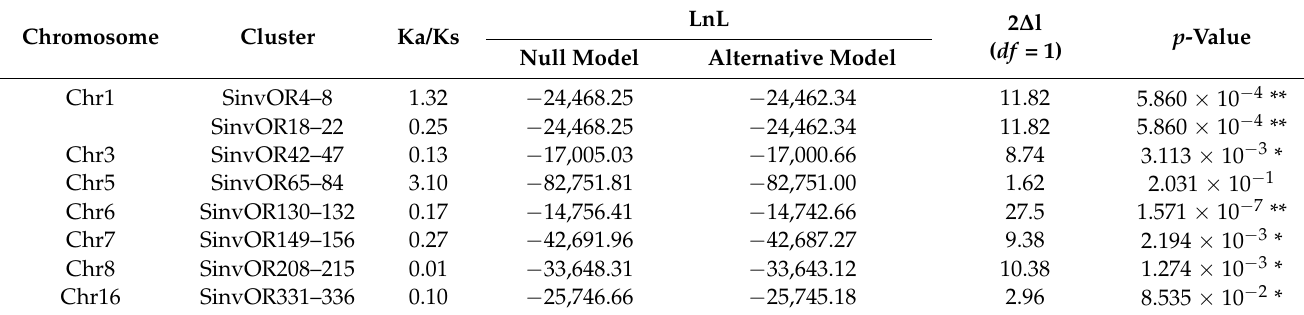
Table 1. Selective evolutionary pressure calculated for 9-exon OR clades on a single chromosome of S. invicta .